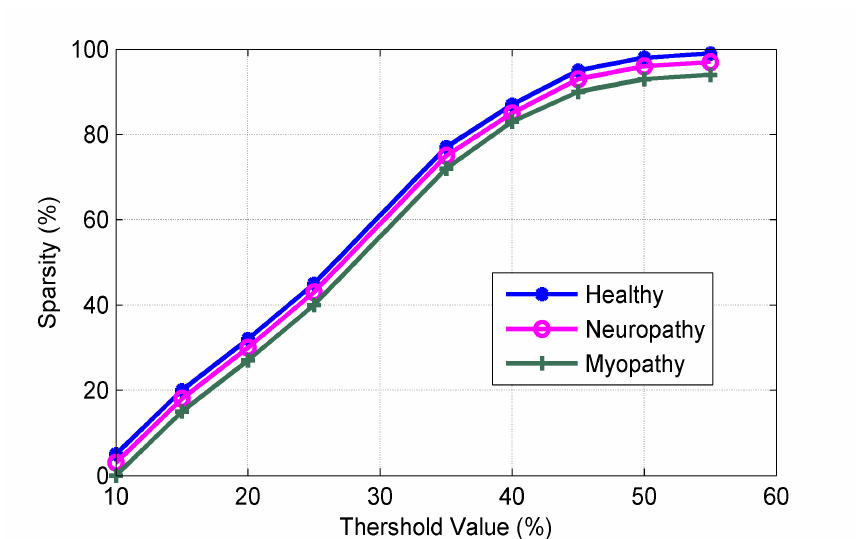
Figure 9. Sparsity